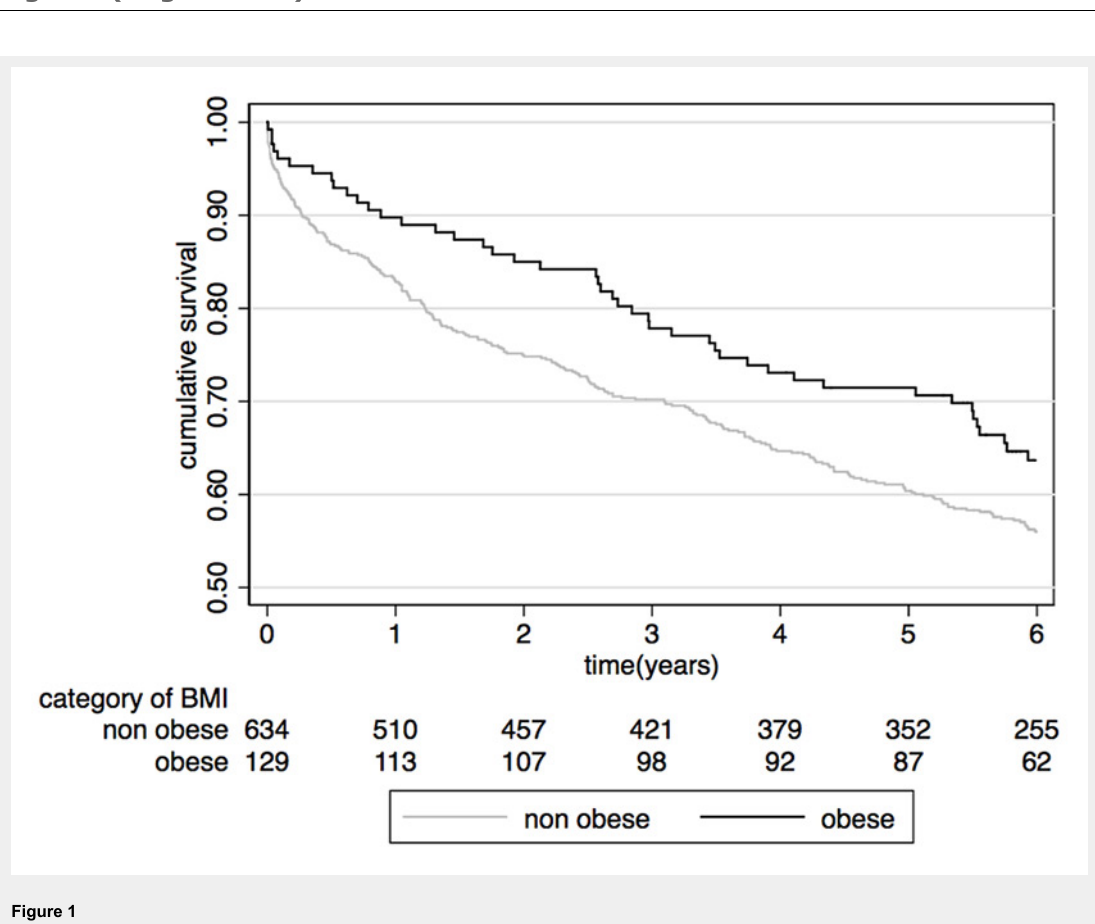
Association between obesity and survival in a cohort of patients with community-acquired pneumonia. nonobese = body mass index (BMI) <30 kg/m 2 ; obese = BMI ≥30 kg/m